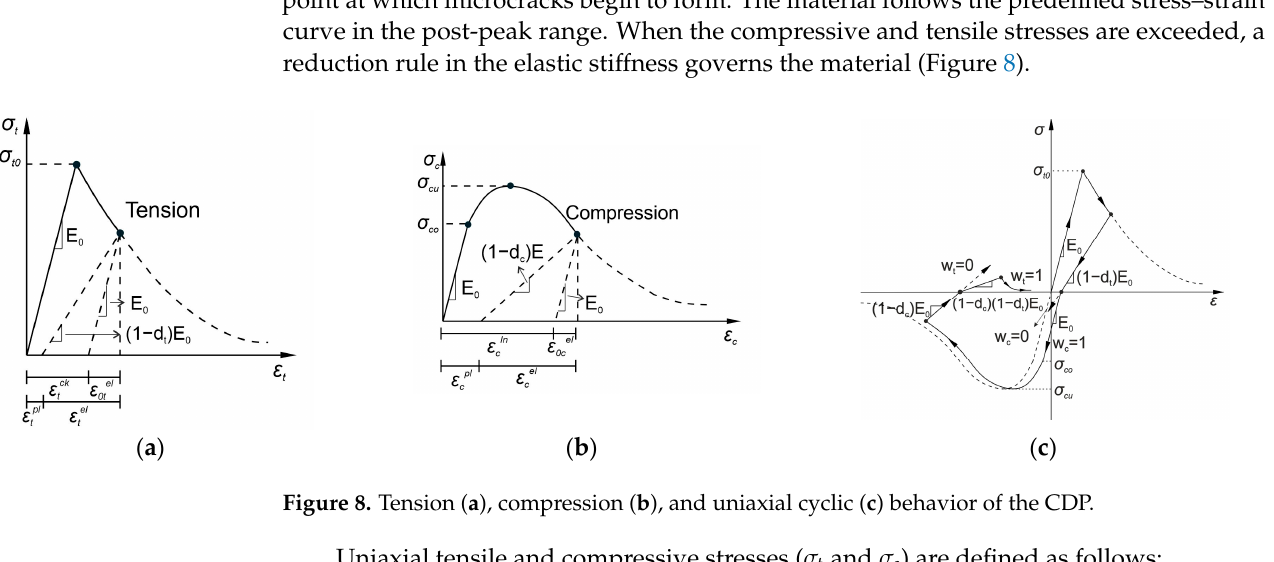
where 𝐸 (cid:2868) is the initial modulus of elasticity, 𝑑 (cid:3047) and 𝑑 (cid:3030) are the scalar damage variables,